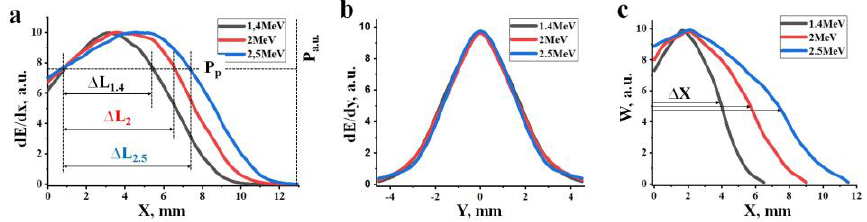
Figure 2. Energy loss distribution profiles dE/dx ( a ) and dE/dy ( b ) of electrons with energies of 1.4, 2.0, and 2.5 MeV in the mixture and absorbed energy density W ( c